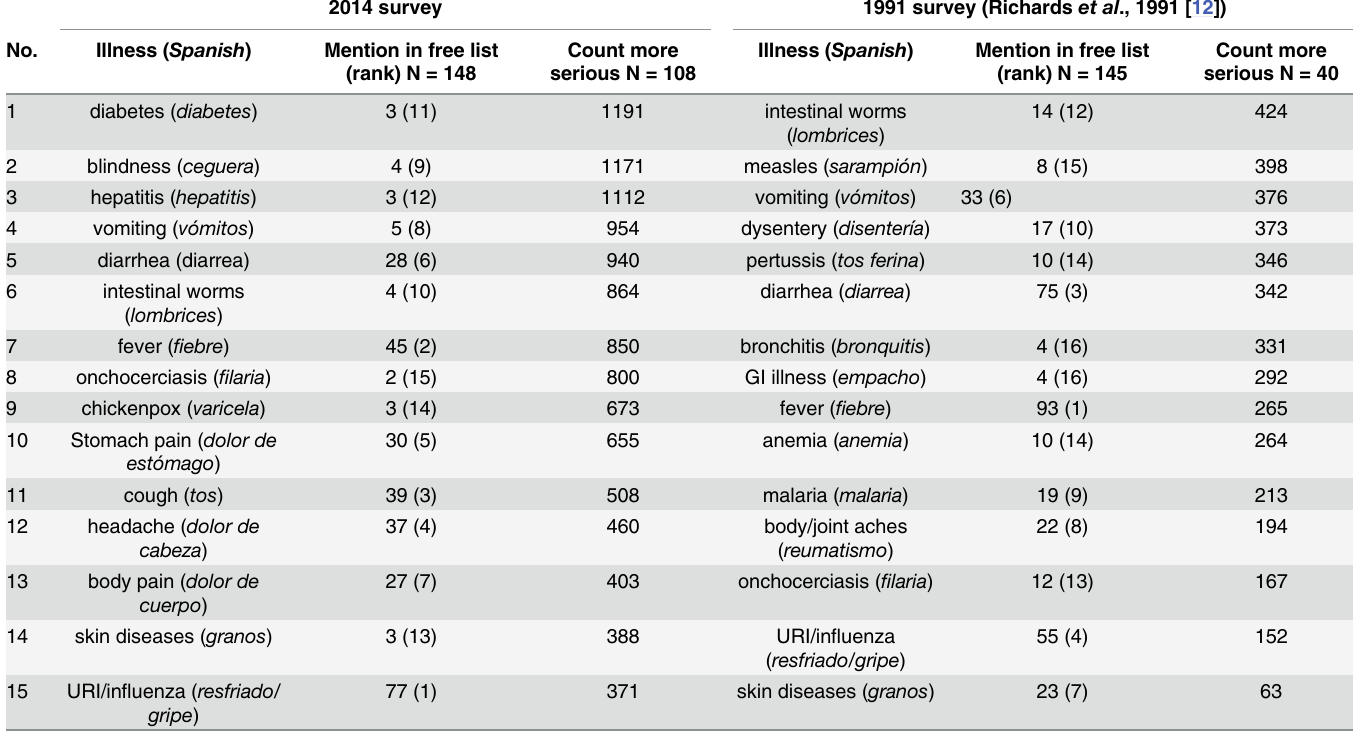
Table 1. Differences in perceived seriousness of onchocerciasis (as determined by “ free-listing ” and paired comparisons) in 2014 compared to 1991. Illnesses are listed in order of seriousness (greatest to least) as determined by paired comparison. The ‘ (Rank) ’ refers to the frequency the illness term was mentioned in the respondents ’ free listings. Spanish terms are given in parentheses in italics. Dysentery ( disentería ), understood as painful diarrhea with blood, is different from diarrhea. URI ( resfriado ) = upper respiratory infection was not distinguished from influenza ( gripe ). 1991 survey (Richards et al ., 1991